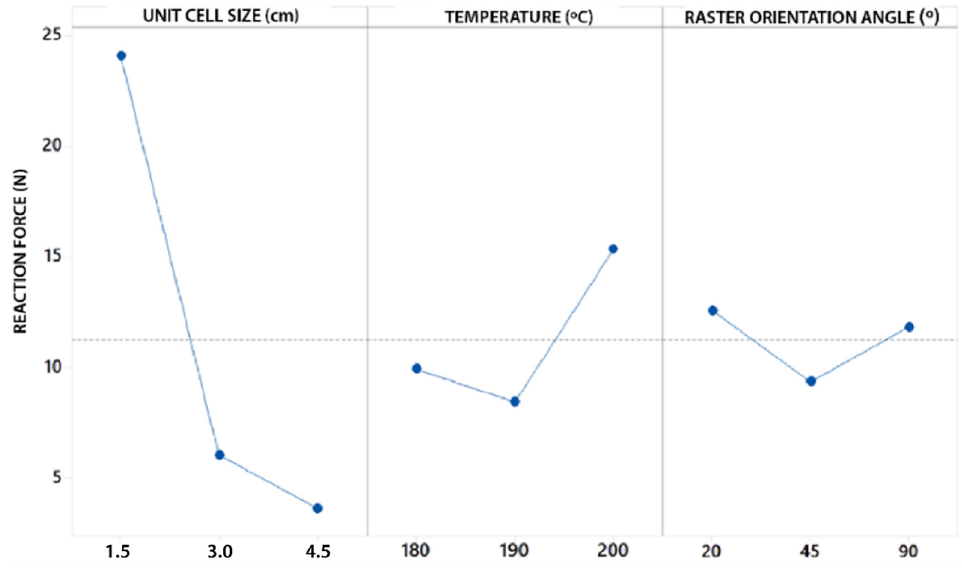
Figure 9. Main effects graph.